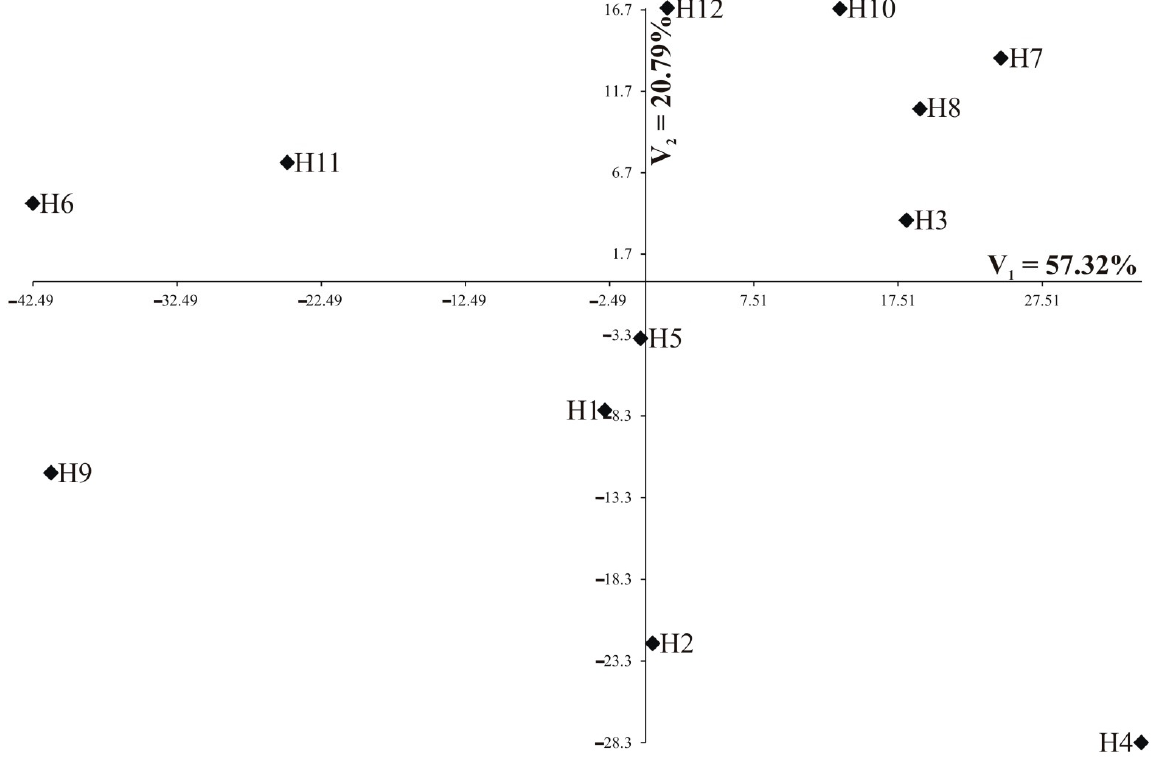
Figure 6. Distribution of 12 hybrids in the space of the first two canonical variables in the vegetative stage (N = 90).